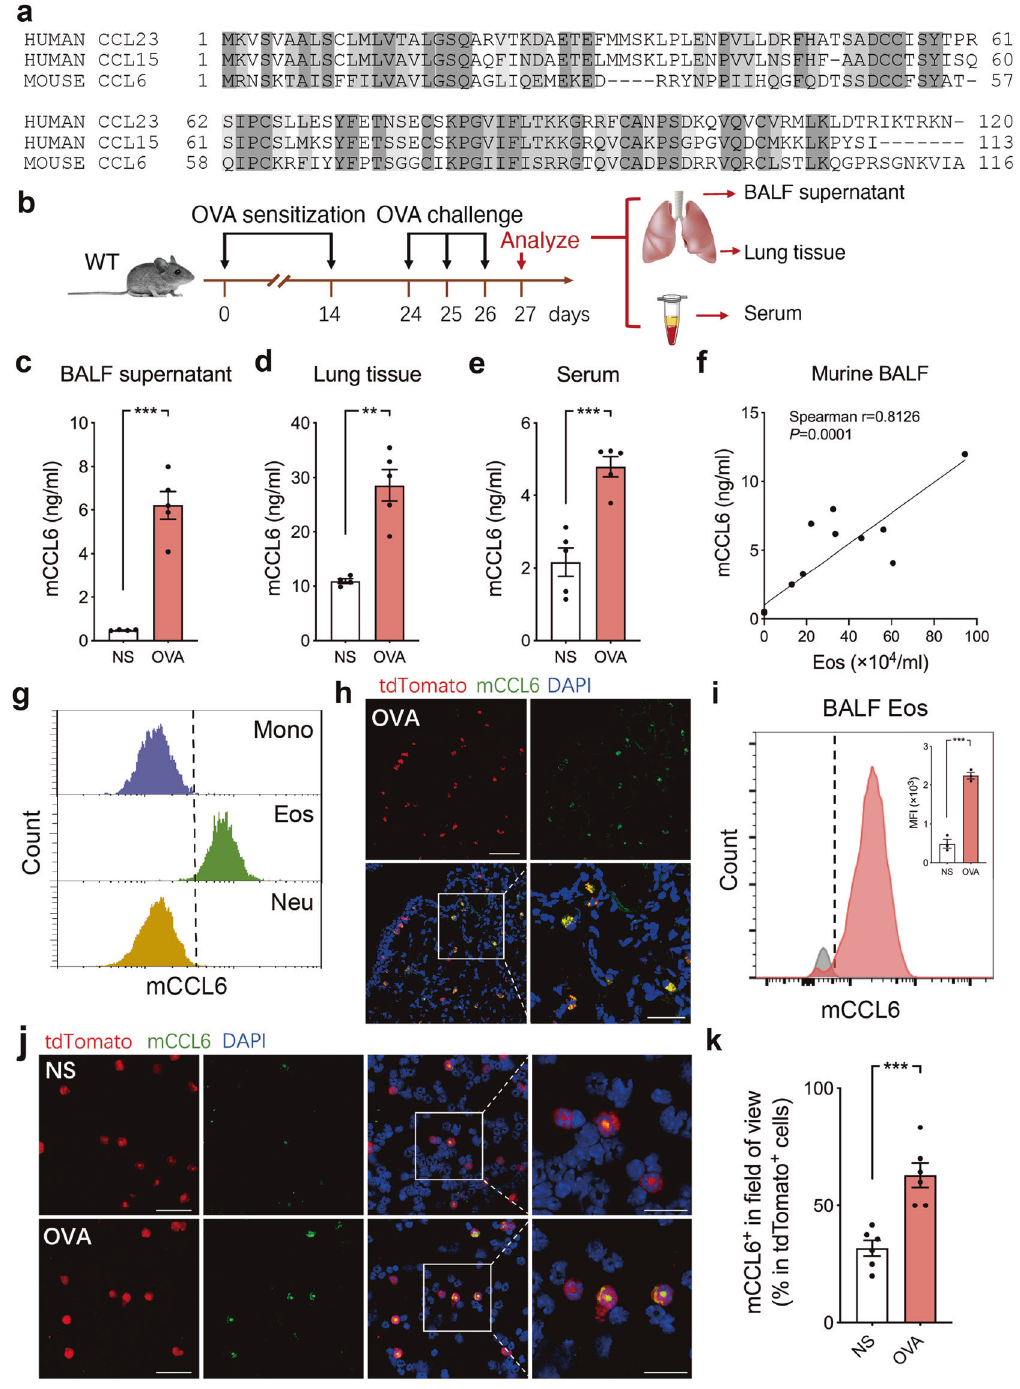
Fig. 2 Increased expressions of eosinophil-derived mCCL6 in allergen-challenged mice. a Sequence alignment of the mCCL6 with the hCCL23 and hCCL15. Shaded letters indicate residues at each aligned position that are identical to the hCCL23 and hCCL15 speci fi city. Dashes indicate gaps that were inserted to optimize the alignment. b Schematic timeline and subsequent sample processing of allergic asthma mouse models. c-e Expressions of mCCL6 in BALF supernatant ( c ), lung tissue ( d ), and serum ( e ) measured by ELISA from NS or OVA-challenged mice. Each point represents an individual mouse; data from 4 – 5 mice per group are plotted as mean ± SEM. f Correlation of mCCL6 protein levels with the number of eosinophils in murine BALF ( n = 17, some of the points are overlapped). g Representative histograms of mCCL6 expression in monocytes, eosinophils, and neutrophils from peripheral blood of NS mice. Cells were gated in Fig. S2a. h Representative lung immuno fl uorescence of eosinophils (tdTomato + , red) in OVA-challenged eoCre/R26-tdTomato mice staining with mCCL6 antibody (green) and DAPI (blue). Scale bar, 40 μ m, 20 μ m. i Representative histograms of mCCL6 expression in BALF eosinophils from OVA-challenged mice compared with NS mice. j Representative cytospin slides of bone marrow exhibited eosinophils (tdTomato + , red) in NS or OVA-challenged eoCre/R26-tdTomato mice staining with mCCL6 antibody (green) and DAPI (blue). Scale bar, 40 μ m. k Quantitation of mCCL6 + percentage among tdTomato + cells in j ( n = 6 per group, 3 images per mouse). ** P < 0.01; *** P < 0.001 by unpaired t -test